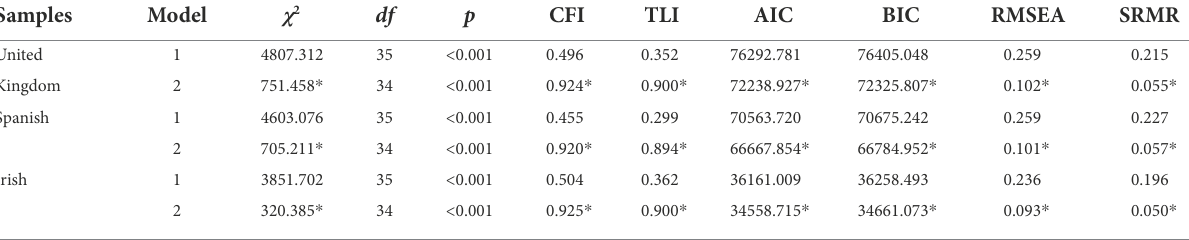
TABLE 2 Model fit paranoia and conspiracy one and two factor model. Samples